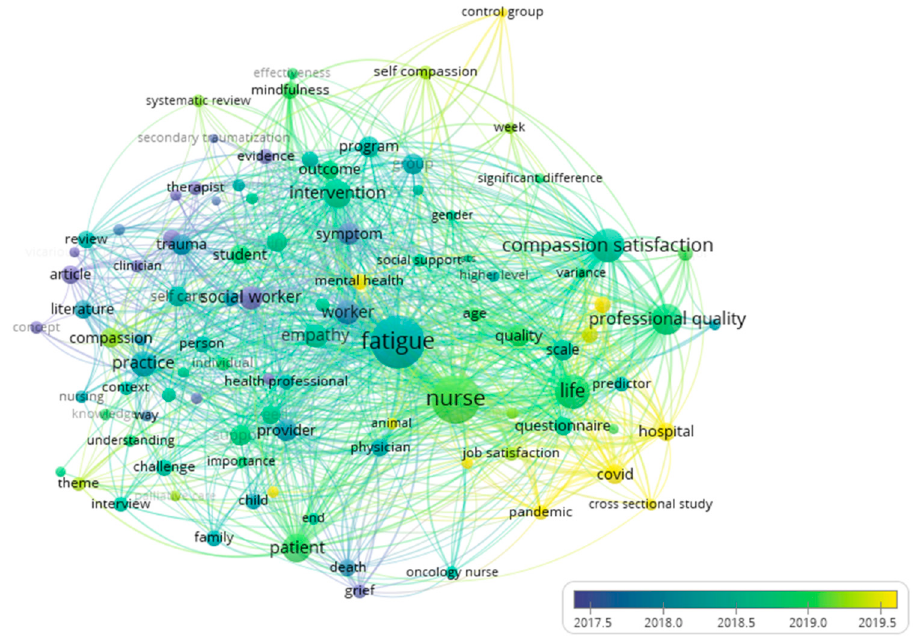
Figure 9. Overlay network of keywords’ co-occurrence.